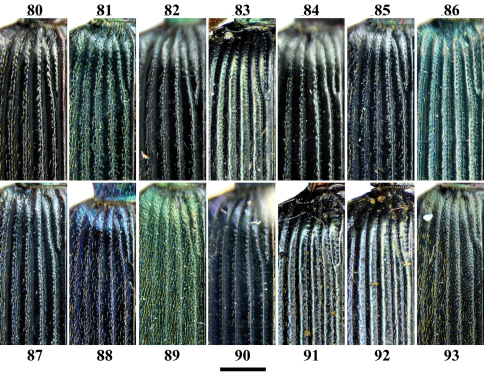
Elytral intervals of Chlaenius (Lithochlaenius) spp. 80 Chlaenius chuanqianensis sp. n., holotype81 Chlaenius linwensini sp. n., holotype82 Chlaenius propeagilis sp. n., holotype83 Chlaenius agilis Chaudoir, holotype84 Chlaenius formosensis Lorenz, CCCC85 Chlaenius leishanensis, IZCAS86 Chlaenius noguchii Bates, IZCAS87 Chlaenius wrasei Kirschenhofer, IZCAS88 Chlaenius agiloides Jedlička, IZCAS89 Chlaenius rambouseki Lutshnik from Ussuri region, IZCAS90 Chlaenius anchomenoides Bates, paratype91 Chlaenius nuristanusJedlička, paratype92 Chlaenius nuristanus Jedlička, paratype93 Chlaenius rambouseki Lutshnik from Taiwan,CCCC. Scale line = 1.0 mm.